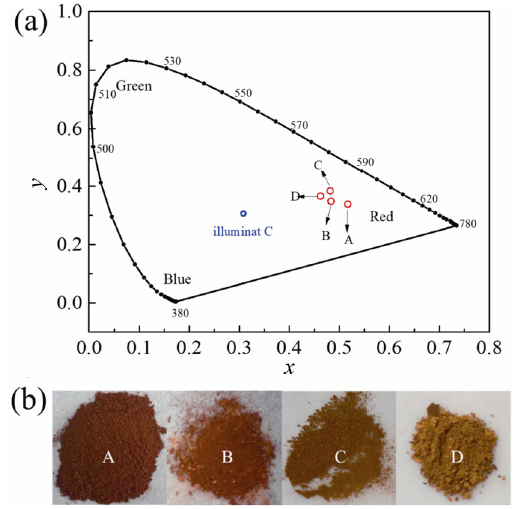
Fig. 10 (a) Chromaticity coordinates and (b) photograph of the α-Fe 2 O 3 @SiO 2 pigments with various shell thickness.